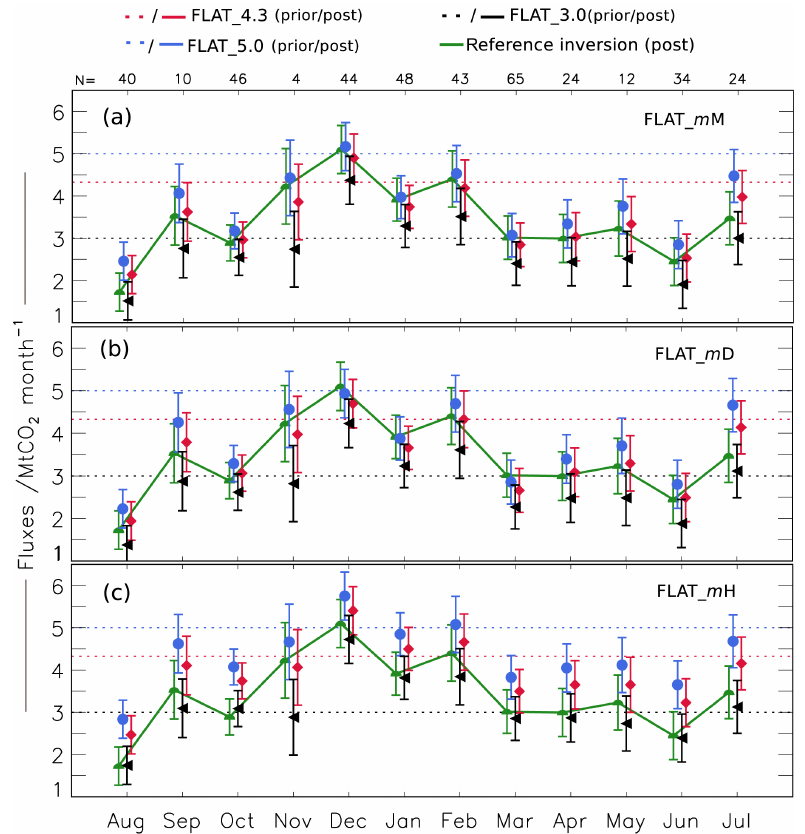
Figure 6. Sensitivity of monthly fossil fuel CO 2 emissions on x b . Monthly fossil fuel CO 2 estimates ± the standard deviation of their uncertainties are shown for inversions that use 3MtCO 2 month − 1 (black), 4.3MtCO 2 month − 1 (red), and 5MtCO 2 month − 1 (blue) monthly prior emissions. (a) Priors are flat at monthly scale (FLAT_ m M, m = 3 . 0, 4.3 or 5.0MtCO 2 month − 1 ). (b) Priors are flat at daily scale (FLAT_ m D). (c) Priors are flat at 6h scale (FLAT_ m H); see Sect. 2.6 for details. Fluxes obtained by the reference inversion (green). Numbers at the top denote the number of assimilated CO 2 mole fraction gradients. Symbols are shifted slightly to prevent